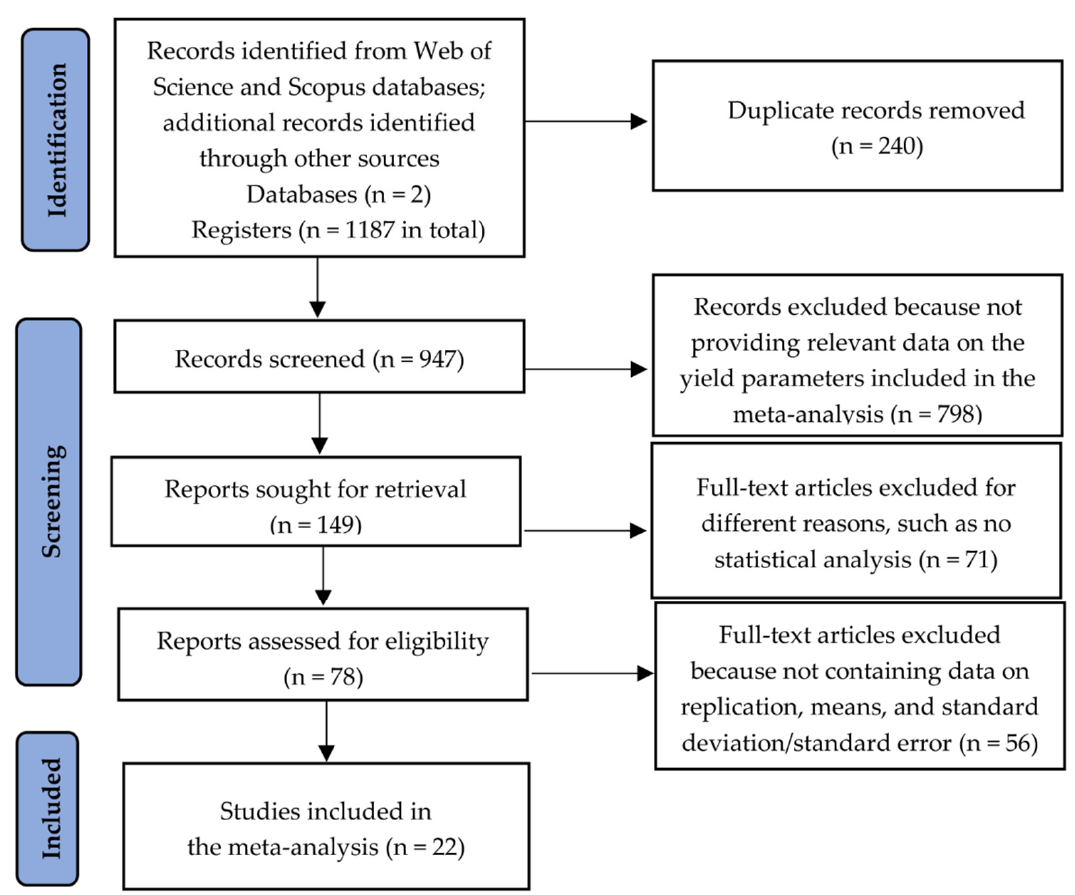
Figure 1. PRISMA flow diagram. Table 1. Most common use and breeding system in the cultivated crops of the family Brassicaceae included in this study. In self-compatible plants, both outcrossing and selfing occurs, while in self- incompatible ones, the main breeding system is outcrossing.